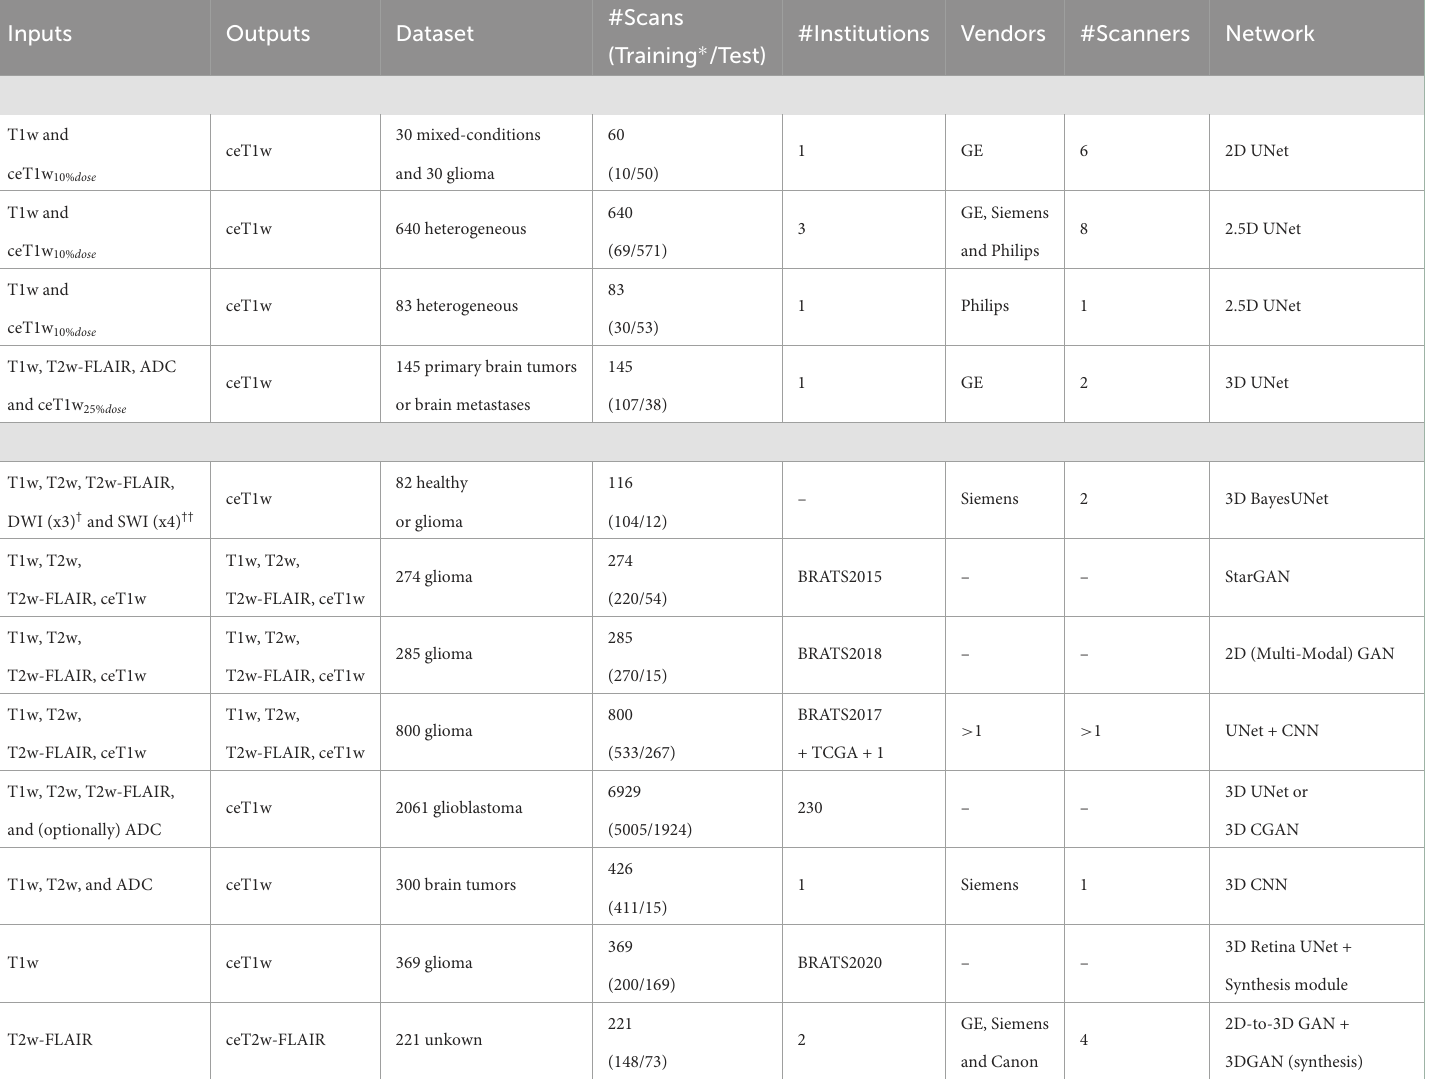
TABLE 1 Summary of the DL synthesis works reviewed.